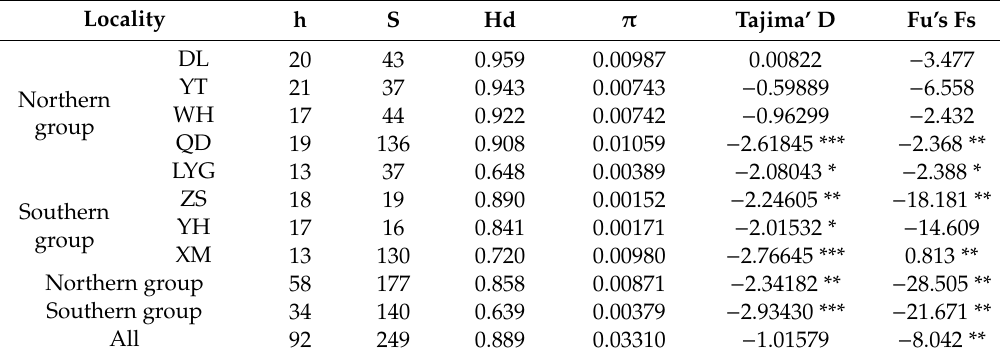
Table 2. Genetic diversity parameters based on COI and 16S rRNA sequences of A. rubrolineatus. Locality h S Hd π Tajima’ D Fu’s